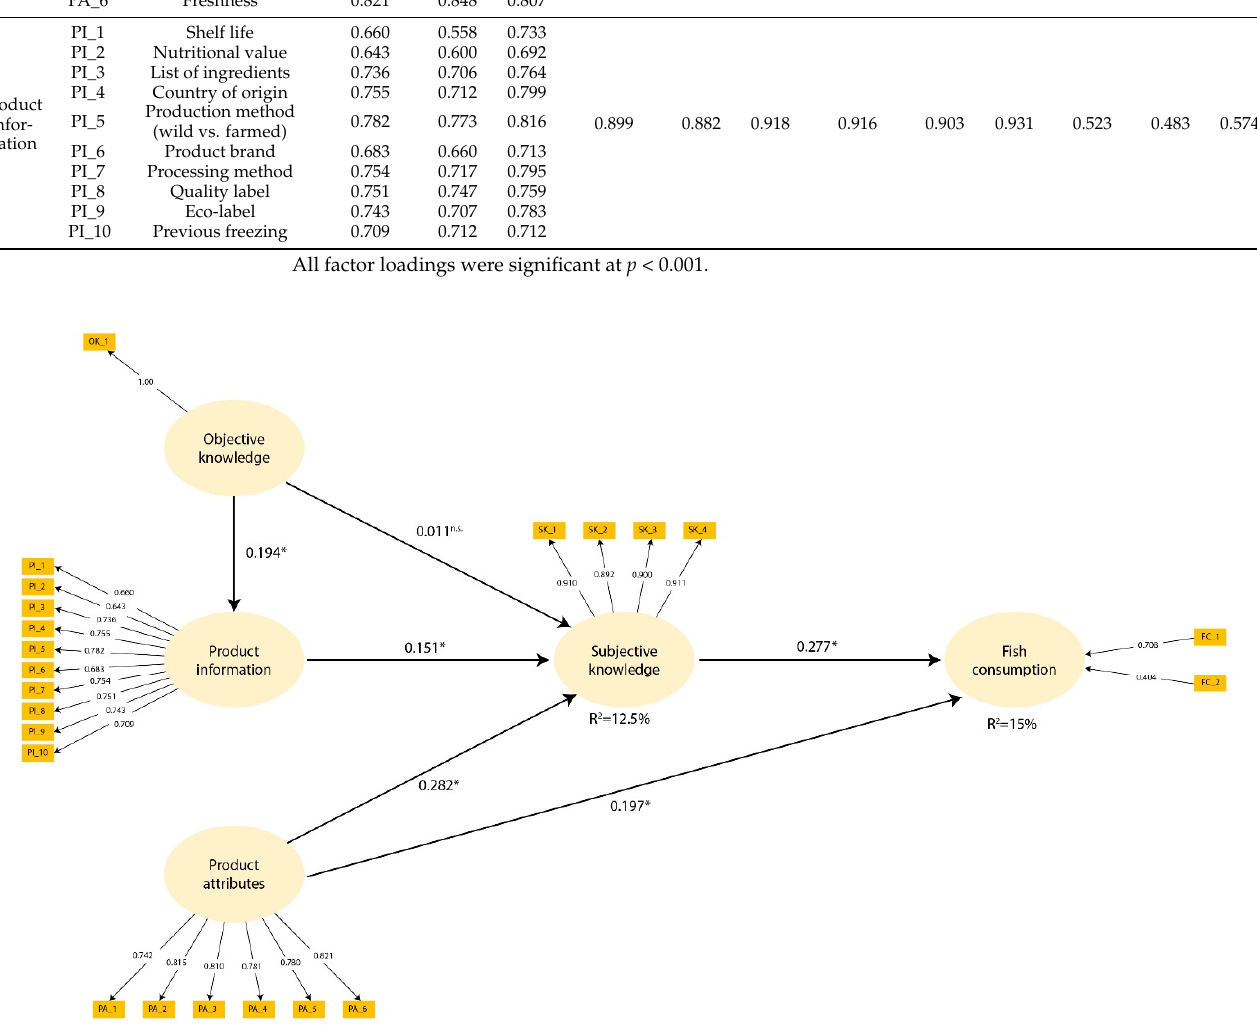
Figure 3. Measurement and structural model of total sample. * p < 0.001; n.s = non significant. Table 4. Reflective measurement models.